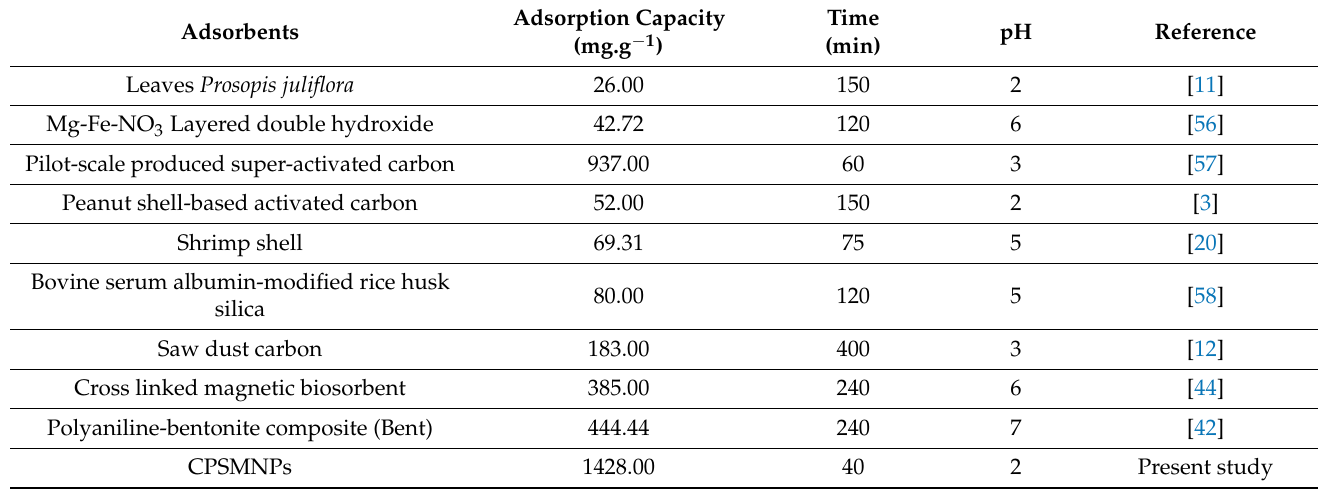
Table 7. Comparison of adsorbent for the adsorption of MY of the present study with literature- reported